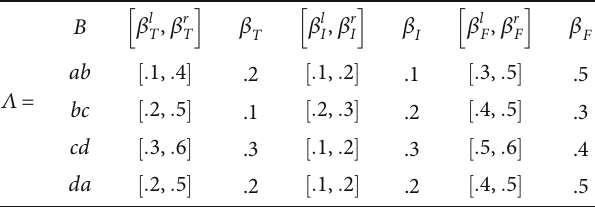
Table 7: Neutrosophic membership functions for